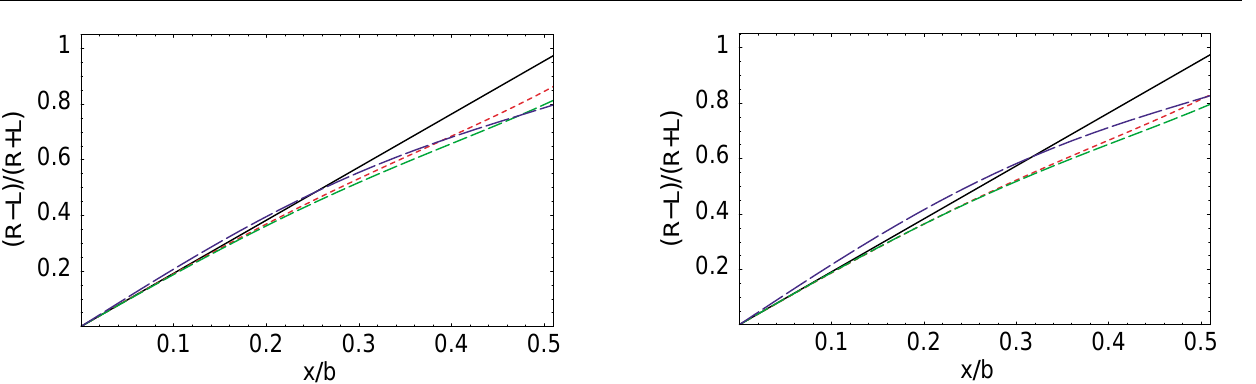
FIG. 2. (Color) Beam position monitor (BPM) signal ratio (7) in a circular chamber versus beam center position x (cid:2) b for three ver- tical beam offsets y (cid:2) b (cid:1) 0, 1 (cid:2) 4, 1 (cid:2) 2 (short-dashed line, dashed line, long-dashed line, respectively) without beam-size correc- tions (pencil beam, s x (cid:1) s y (cid:1) 0 ). The solid line shows the linear part of the BPM response.